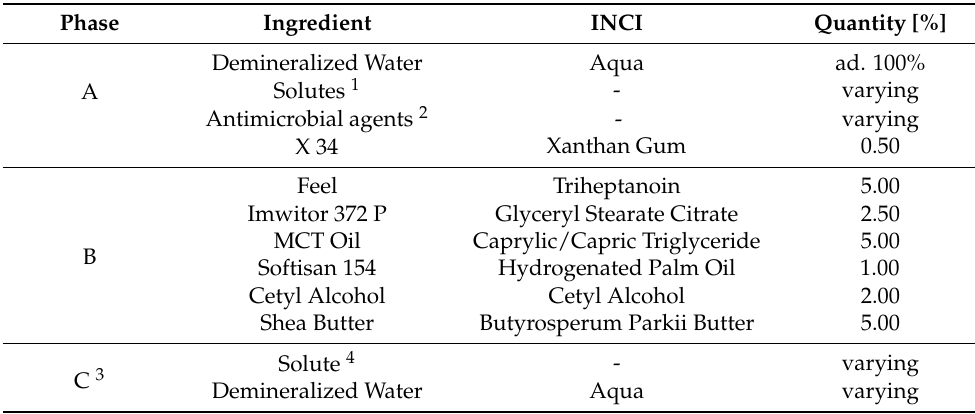
Table 3. Basic composition of the studied o/w